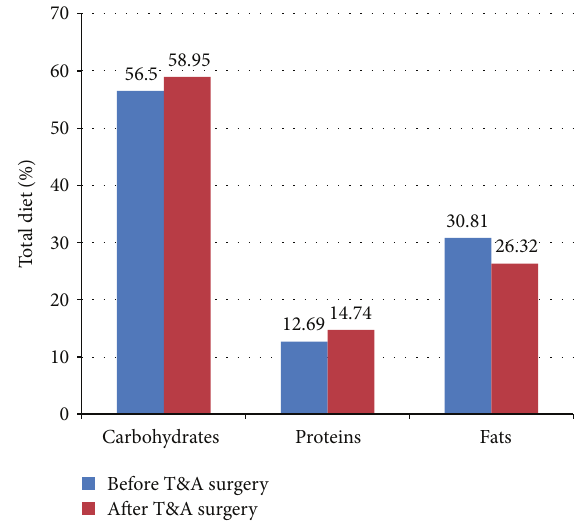
Figure 2: A graphic presentation of the change in dietary composi- tion before and after T&A surgery. A rise in % carbohydrates (NS) and % proteins intake ( 𝑃 = 0.045 ) was noted, accompanied by a decrease in % fat ( 𝑃 = 0.016 ) in diet.